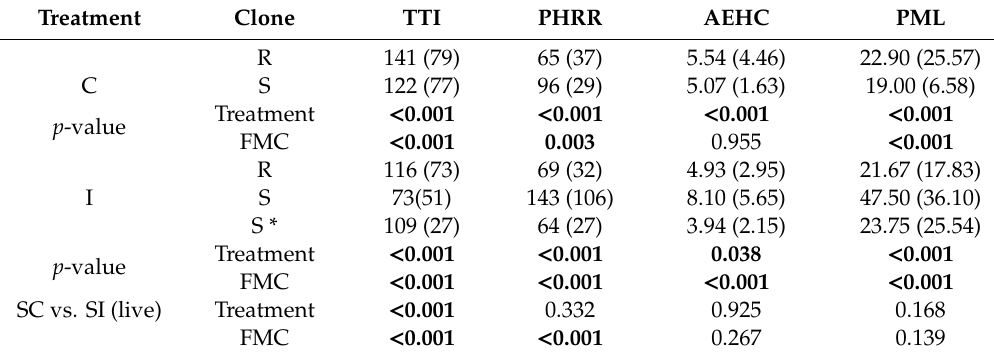
Table 5. GLMM of the flammability parameters from the control (C) and the infected (I) treatments of the resistant (R) vs. susceptible (S) common cypress clones for the following variables: TTI (time to ignition, s), PHRR (peak heat release rate, kW / m 2 ), AEHC (average e ff ective heat of combustion, MJ / Kg), PML (percentage of mass lost, %). The average and standard deviation (in brackets) for each variable and treatment are shown (N = 9). The fuel moisture content (FMC) is used as a covariable. The model for the SI treatment was repeated removing dead samples (*). The p -value indicates the significance of the fixed variables (clone, R vs. S). The factor ramet is included in the model as a random variable. Significant di ff erences ( > 95%) are highlighted in